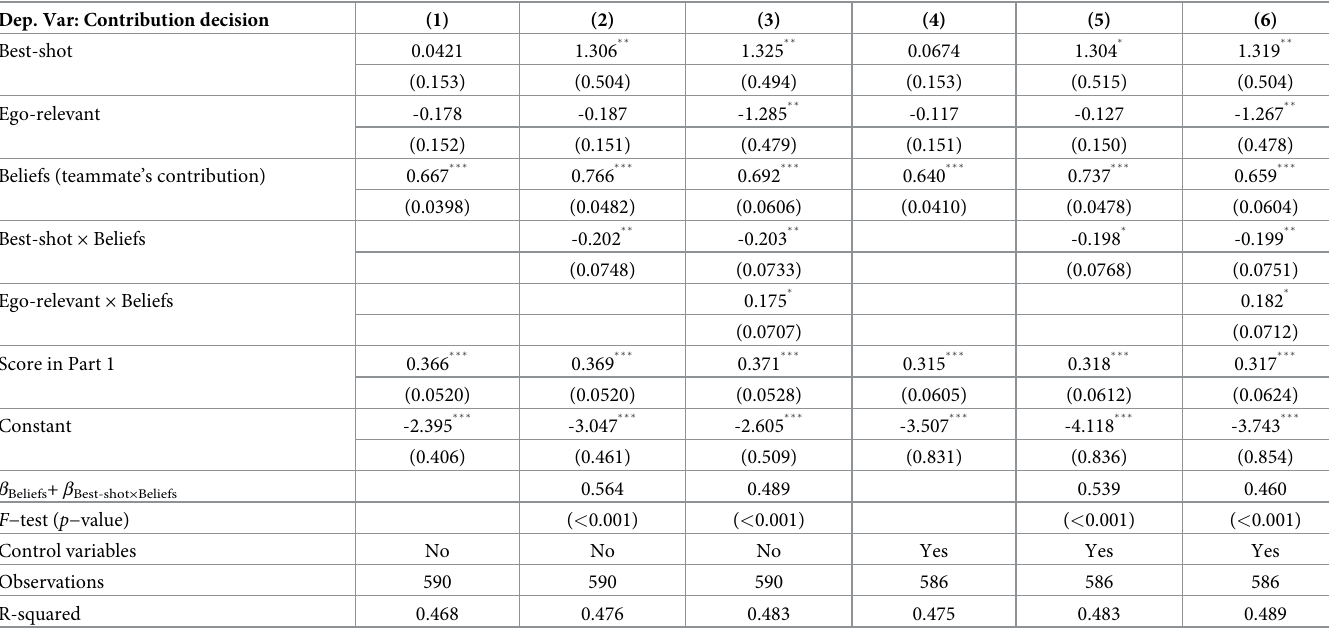
Table 4. OLS predictions for the contribution